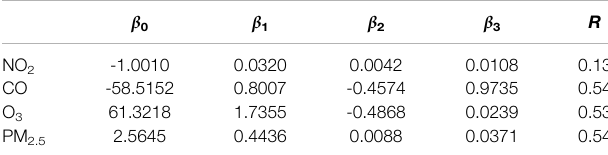
TABLE 2 | Resultsshowing the offsets and coef fi cients ofthe in- fi eld calibration at SMEAR III. The Pearson correlation coef fi cients ( R ) of the in- fi eld calibration is shown in the last column of the